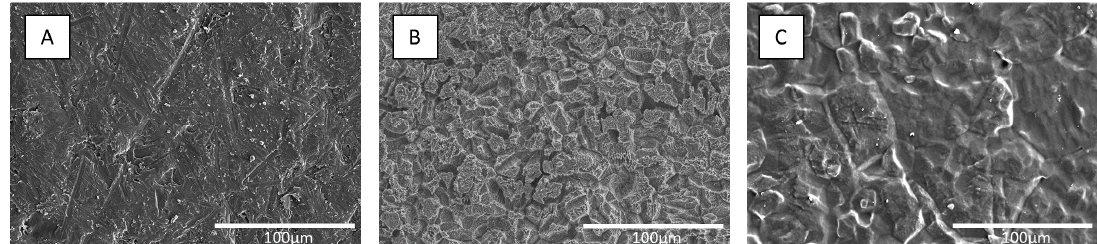
Figure 9. Scanning electron microscopy (SEM) of titanium (Ti6Al4V) substrates and coated surfaces. ( A ) Polished Ti6Al4V was flat with smoothly scalloped surfaces; ( B ) acid-etched Ti6Al4V had extensive surface fissures that created microscale roughness; ( C ) hybrid coating (60% ChSi) films on acid-etched Ti6Al4V substrates retained microtopographical features and surface roughness. SEM analyses were representative and consistent across all coatings.